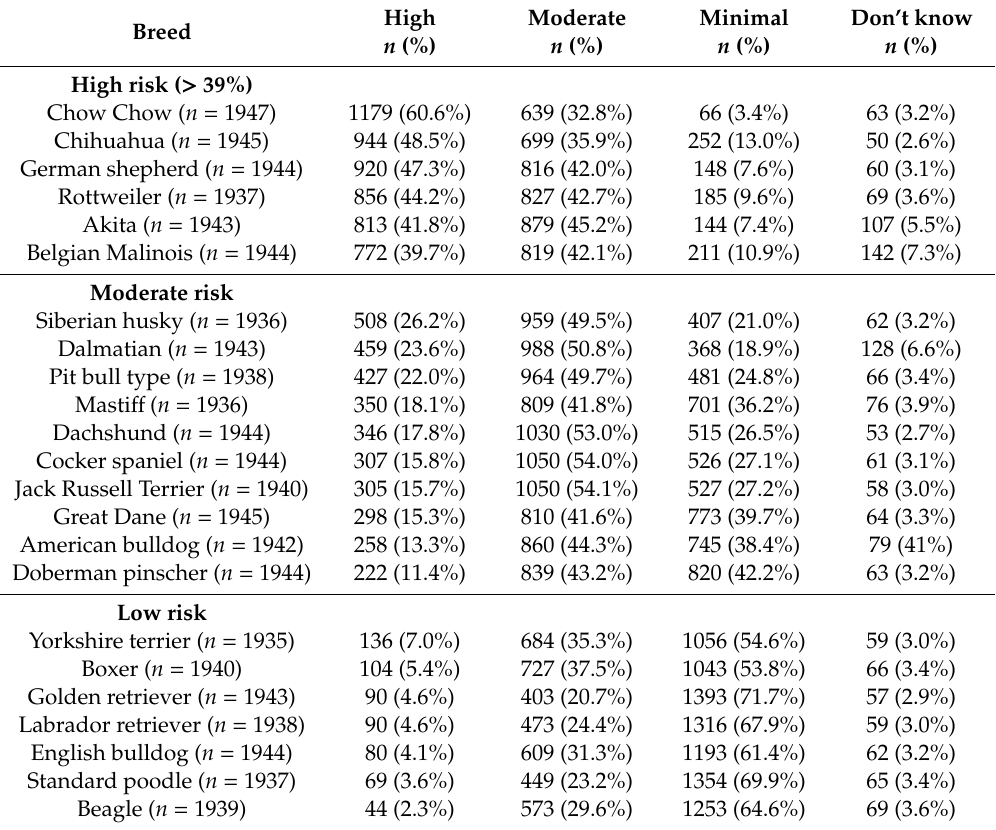
Table 6. Veterinarians’ perceptions of serious bite risk of 23 common U.S. dog